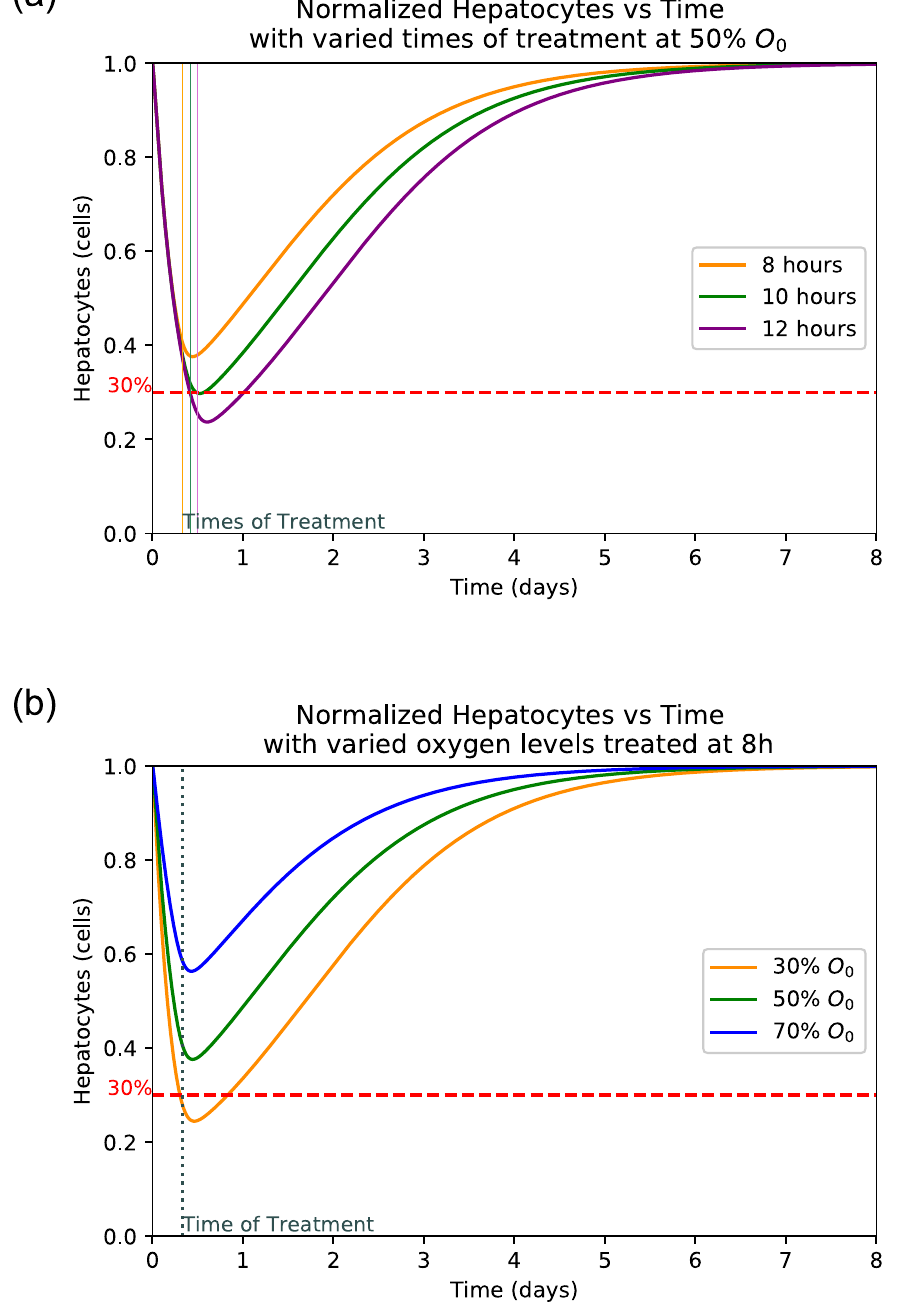
Fig 8. Hepatocyte damage with varied times of treatment and oxygen levels. ( a ) Healthy Hepatocytes as function of normal with varied times of treatment at 50% oxygen level. ( b ) Healthy Hepatocytes as a function of normal with varied initial oxygen levels treated after 8